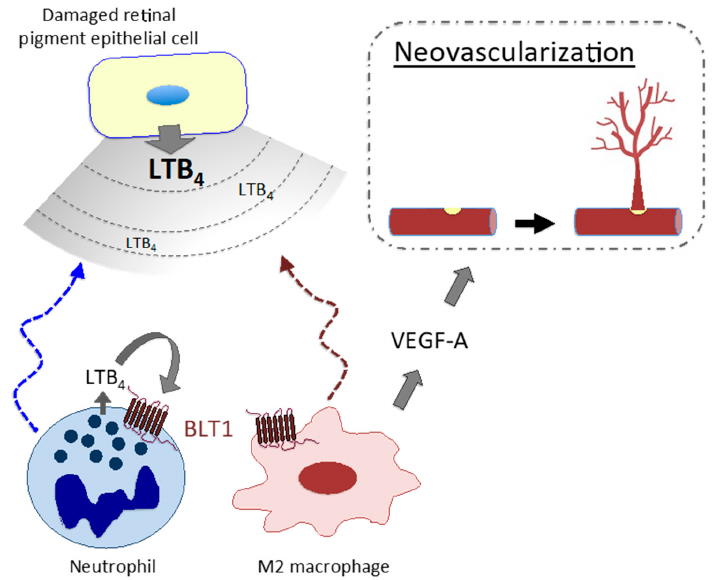
Figure 2. M2 macrophages promote abnormal (pathogenic) neovascularization in age-related macular degeneration via the LTB 4 –BLT1 signaling